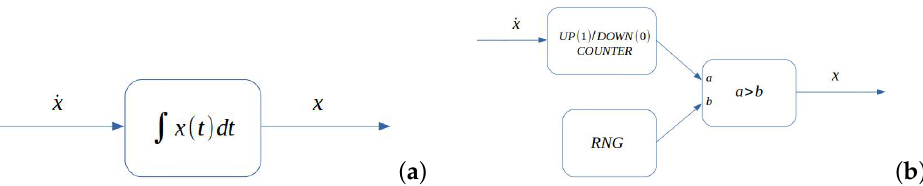
Figure 3. ( a ) Symbol for the integrator block; ( b ) Basic implementation scheme of a SC integrator. Notice that both the input ˙ x ( t ) and the output x ( t ) are SEN